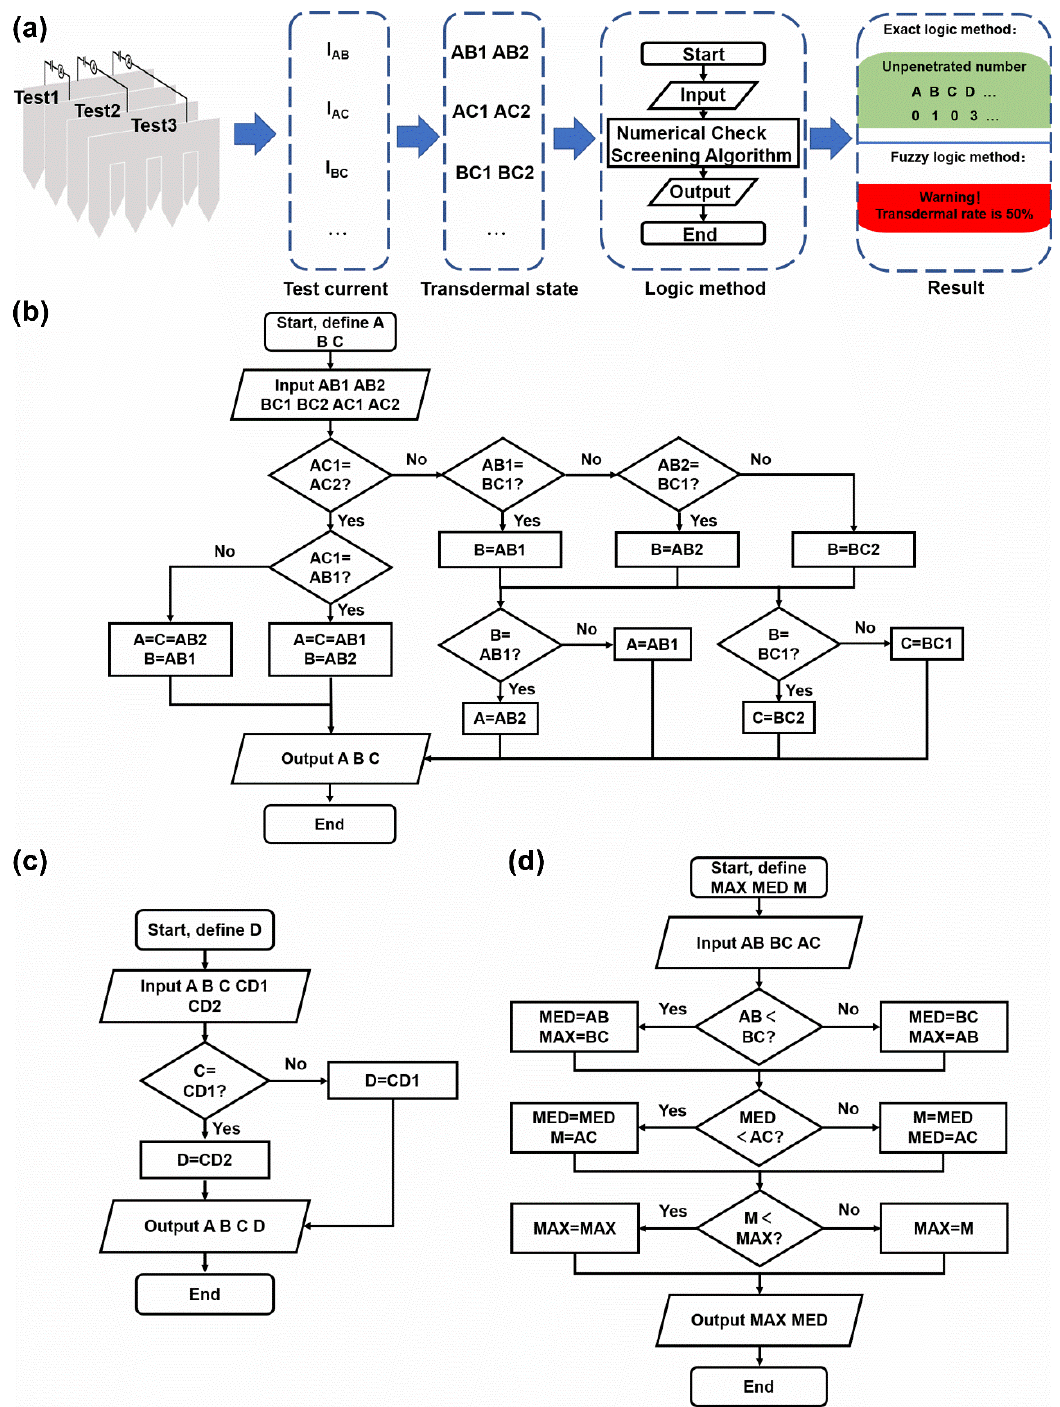
Figure 7. The logical principle for transdermal rate evaluation via the test current. ( a ) The workflow of the designed logic judgment system. ( b ) The logic diagram of the exact logic method for the three sheets area. A, B, and C were the unknown variates referring to the N exact of the microneedle sheet A, B, and C. AB1 and AB2 were the input referring to the transdermal state against I AB . Similar definition to BC1, BC2, AC1, and AC2. ( c ) The logic diagram of the exact logic method for the adding sheet. This work branch was based on the result of Figure 7b. D is the unknow variate referring to the N exact of the microneedle sheet D. CD1 and CD2 were the input referring to the transdermal state against I CD . ( d ) The logic diagram of the fuzzy logic method for the three sheets area. MAX and MED are the unknow variates referring to N MAX and N MED , and Variate M is the temporary storage. AB, CD, and EF are the input referring to the N max-s for the corresponding sheet pairs.